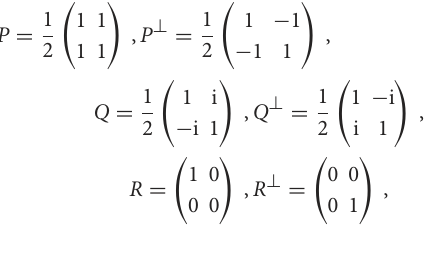
The ontic description refers to the intrinsic nature of a system. By contrast, an epistemic description applies